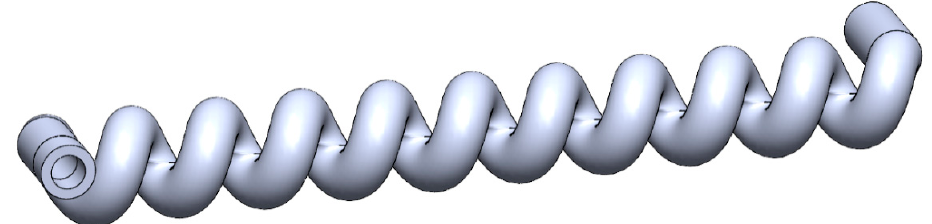
Figure 6. Helical pipe